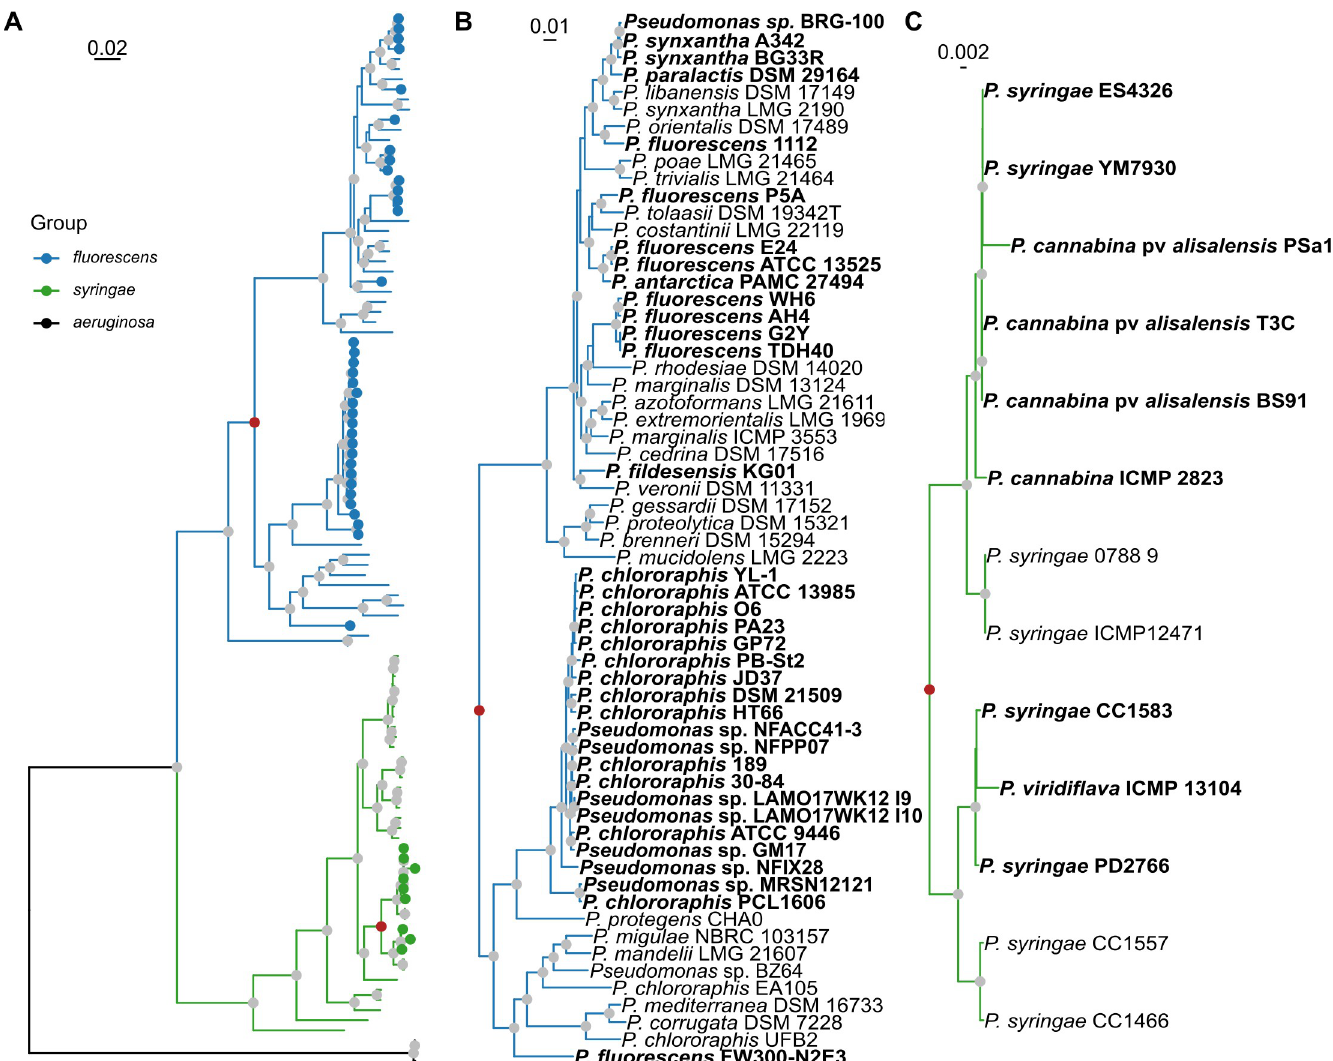
Fig 2. The gvg locus has a patchy distribution in genomes within the Pseudomonas genus. (A) Full maximum likelihood phylogenetic tree based on 99 housekeeping genes. The fluorescens and syringae groups are highlighted in blue and green, respectively. Red nodes correspond to the expanded clades in B and C. (B) Expanded P . fluorescens clade. (C) Expanded P . syringae clade. The tree was rooted on P . aeruginosa . Strain names in bold contain a gvg cluster. Nodes indicated with a gray circle are well supported ( > 95% UF-bootstraps & > 80% SH-aLRT replicates). Genome accessions are listed in S1 Table